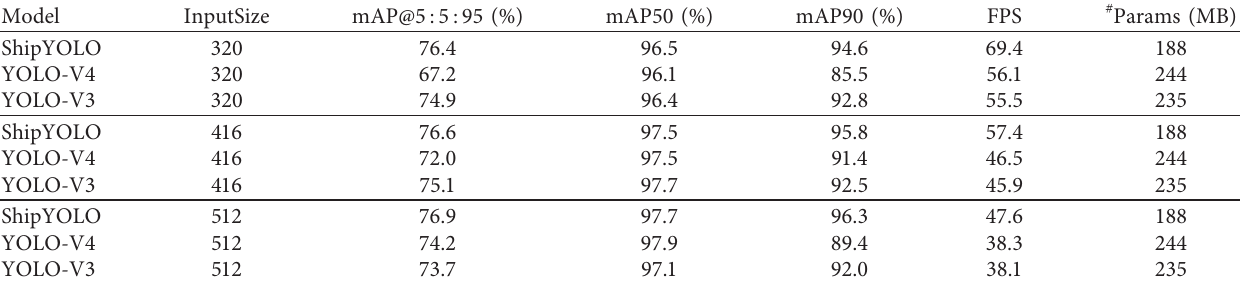
Table 3: Experimental results of the dataset by